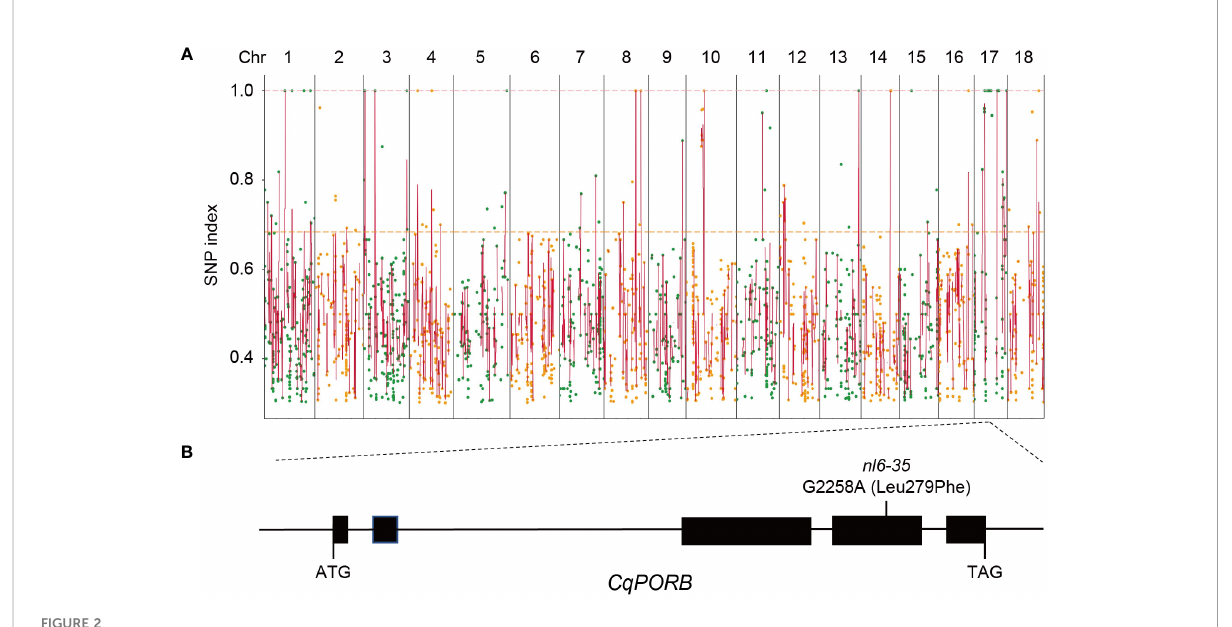
FIGURE 2 Identi fi cation of the mutated genes in nl6-35 using BSA-seq analysis. (A) Identi fi cation of SNPs in nl6-35 using the F 2 hybridization population of the nl6-35 mutant with its parent NL-6. Round dots indicate all the SNPs with a C to T or G to A change in the nl6-35 mutant. X axis indicates the distribution of SNPs on all 18 chromosomes in quinoa. Y axis indicates the SNP index of each SNP. (B) Diagram illustrating the genomic structure of CqPORB gene. The G2258A mutation (Leu279phe) in nl6-35 mutant is